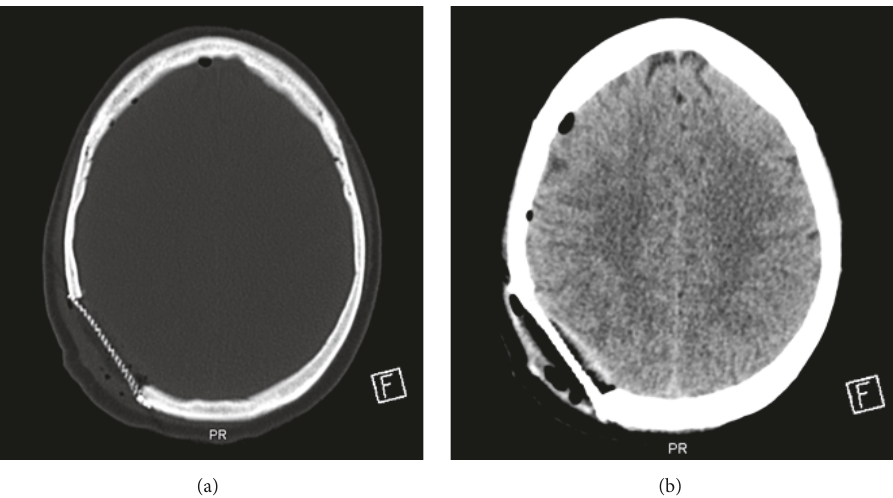
Figure6:Postoperativenonenhanced(a)bonewindowand(b)brainwindowaxialCTshowingametallicmeshoverthesiteofbonyresection, with no associated intracranial hemorrhage or residual bony